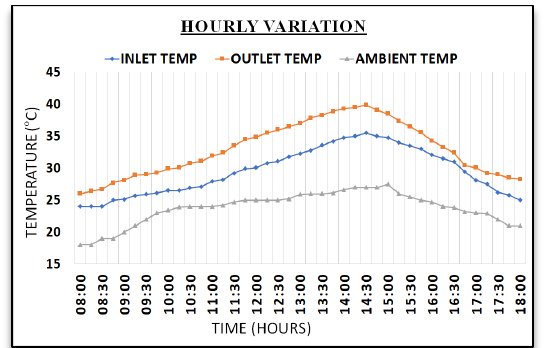
Figure 13. Temp vs Time values observed on a foggy day with sunny day